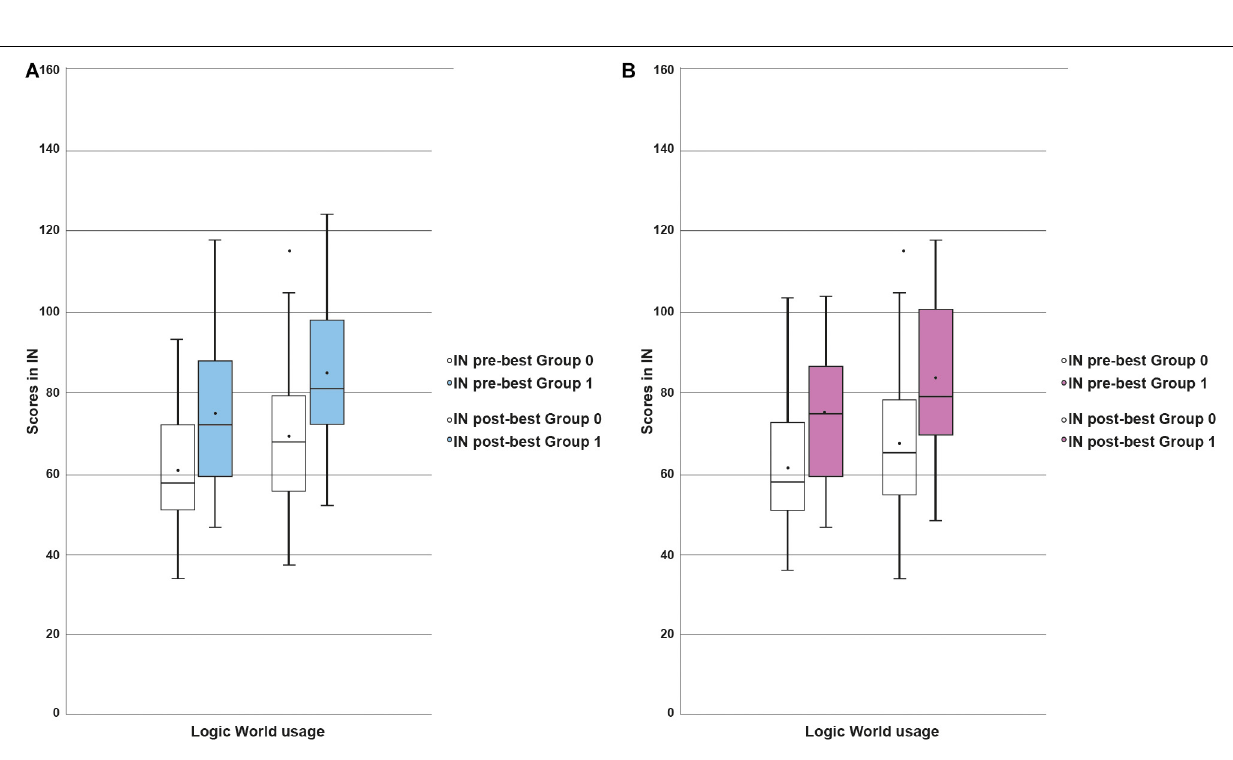
Frontiers in Education |